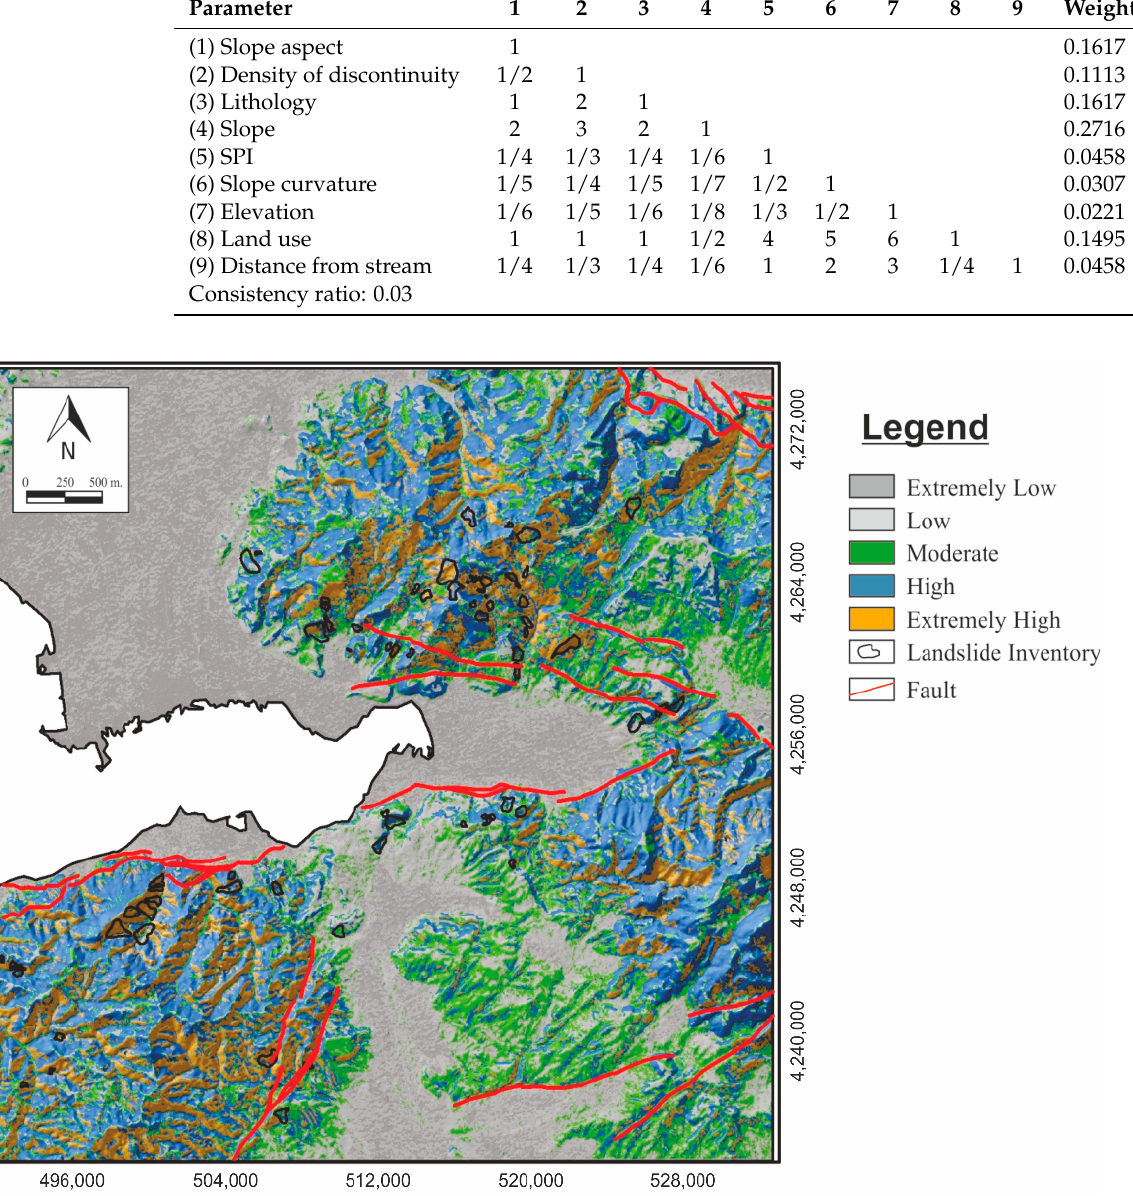
Figure 8. Landslide susceptibility map prepared with AHP method.